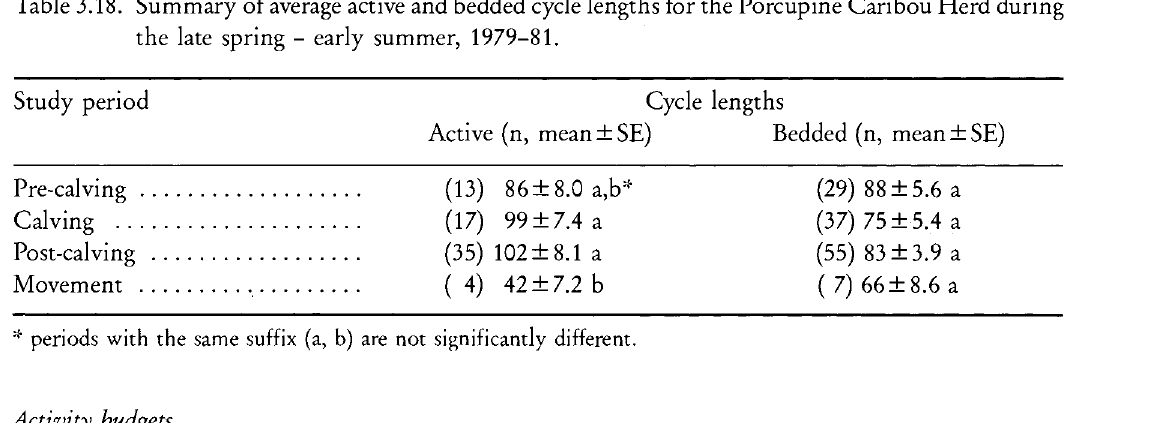
Table 3.18. Summary of average active and bedded cycle lengths for the Porcupine Caribou Herd during the late spring - early summer,